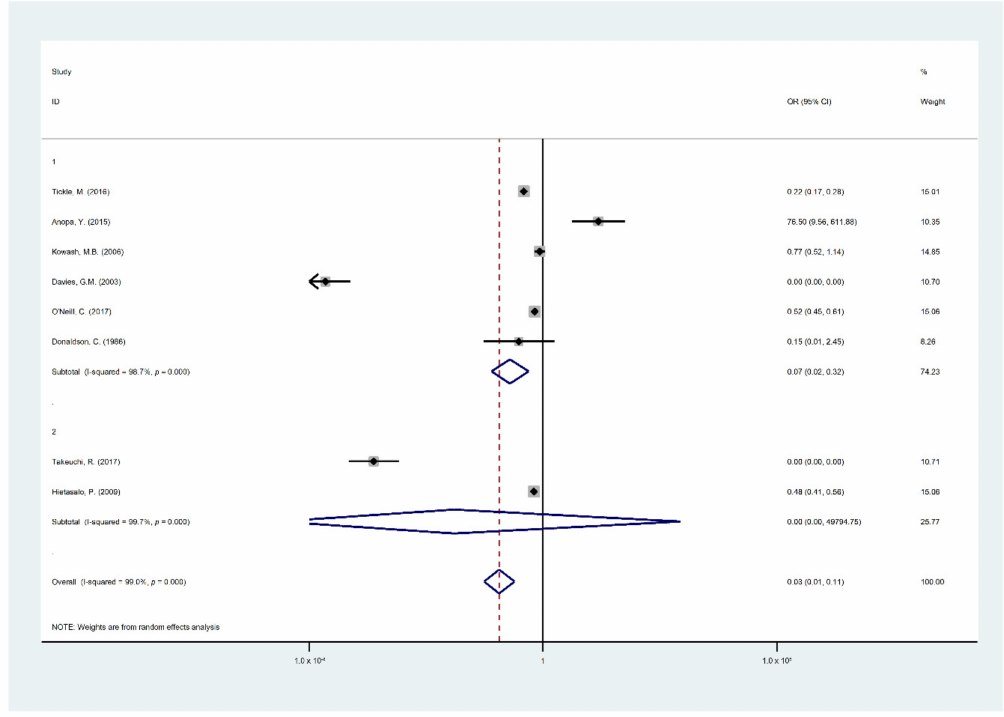
Figure 5. Forest plot of the incremental cost-e ff ectiveness of the intervention and the control groups by the age groups: 1 as (Age > 6) and 2 as (Age ≤